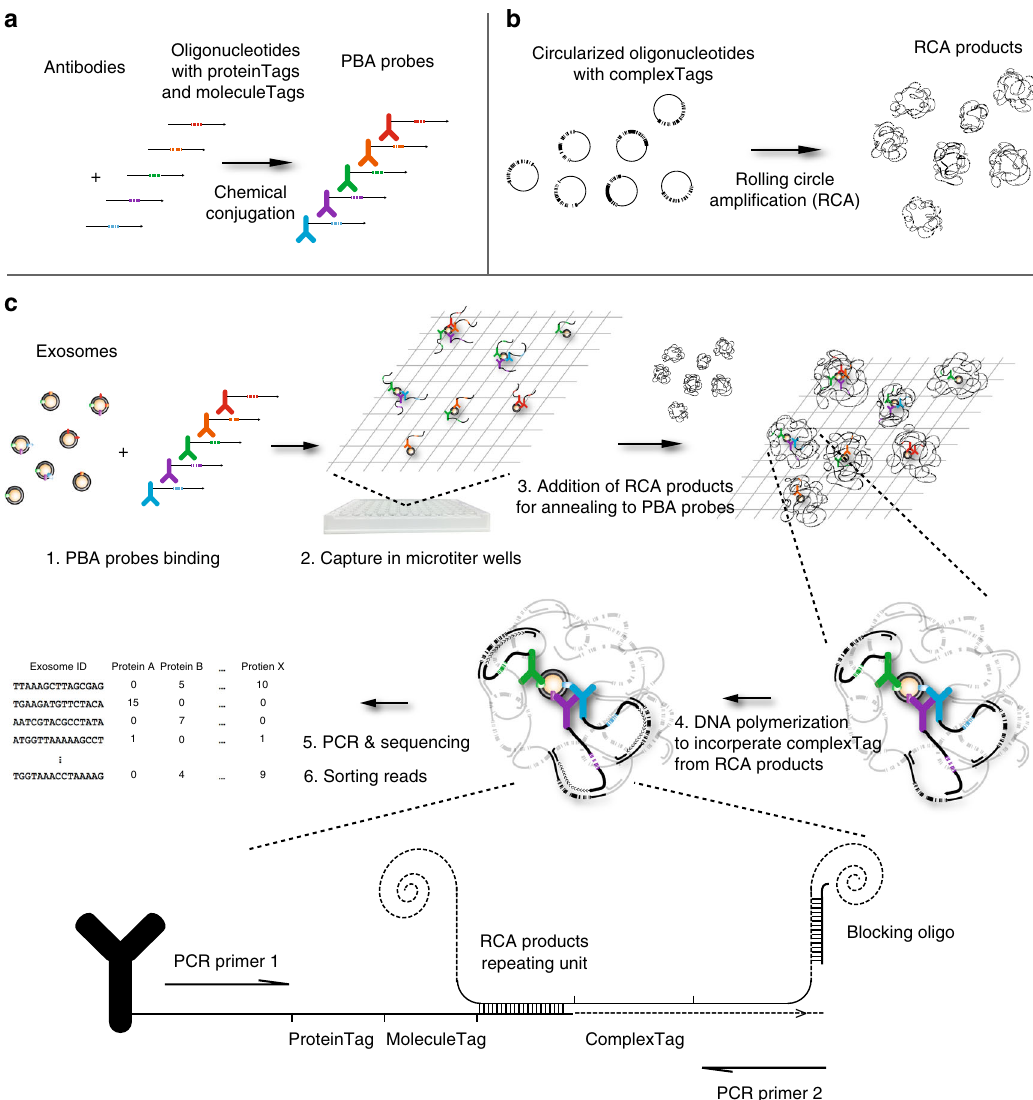
Fig. 1 Design and work fl ow of PBA. a Preparation of PBA probes by chemical conjugation of antibodies and DNA oligonucleotides containing an 8-nt proteinTag and an 8-nt random sequence moleculeTag. b Preparation of RCA products from circularized oligonucleotides comprising a 15-nt random sequence as complexTags, capable of encoding in excess of one billion unique complexTags. c To pro fi le surface proteins of exosomes by PBA, exosomes are fi rst incubated with PBA probes, followed by capture of exosomes with bound PBA probes in microtiter wells via immobilized cholera toxin subunit B (CTB). Oligonucleotides on PBA probes brought together by binding the same exosome are next allowed to hybridize to a unique RCA product, followed by enzymatic extension, incorporating the complexTag present in the RCA product along with a standard sequence motif, later used for ampli fi cation. To prevent the DNA polymerase from extending across nearby monomers in the RCA products, blocking oligonucleotides are pre-hybridized to the RCA products. Successfully extended DNA molecules on PBA probes are ampli fi ed by PCR using the PCR primer1 and PCR primer2 for library preparation, while oligonucleotides on the antibodies or RCA products fail to be ampli fi ed by the PCR primer pairs used for ampli fi cation. The PCR product were subjected to DNA sequencing to record the numbers of molecules with speci fi c tag combinations, thus revealing the identities of proteins on individual